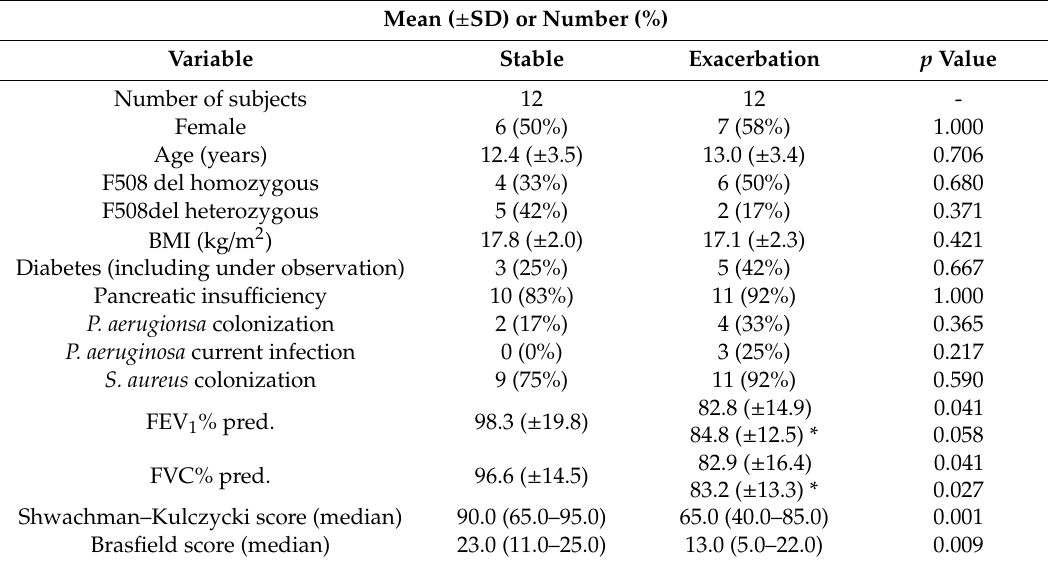
Table 1. Characteristics of the Cystic fibrosis (CF) patients (exhaled breath condensate (EBC) samples).